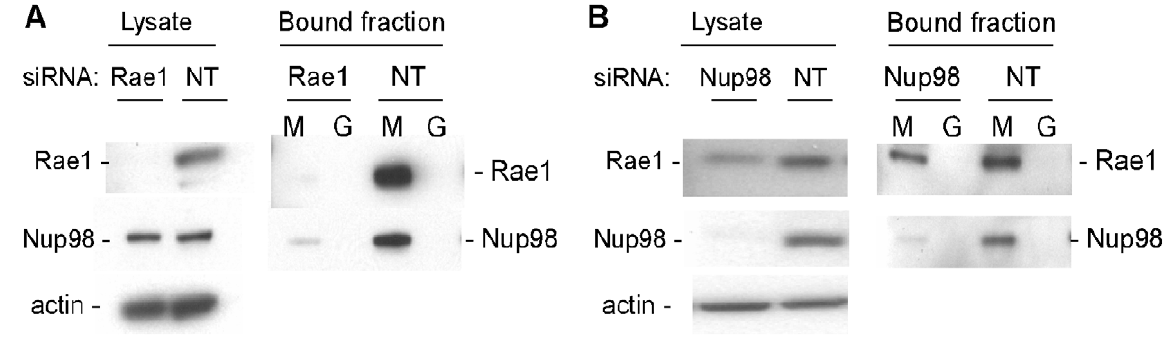
Figure 3. Effects of silencing the expression of Rae1 and Nup98 on interaction with M protein. ( A ) HeLa cells were transfected with Rae1 siRNA or with non-targeting (NT) siRNA. 48 hours post-transfection, lysates from Rae1 siRNA cells or NT siRNA cells were incubated with GST-M protein (M) or GST (G) on glutathione beads for 2 hours at 4 C. Cell lysates and bound fractions were analyzed by immunoblots probed for Rae1 or Nup98. ( B ) Cells were transfected with Nup98 siRNA or with non-targeting (NT) siRNA and analyzed as in ( A ).